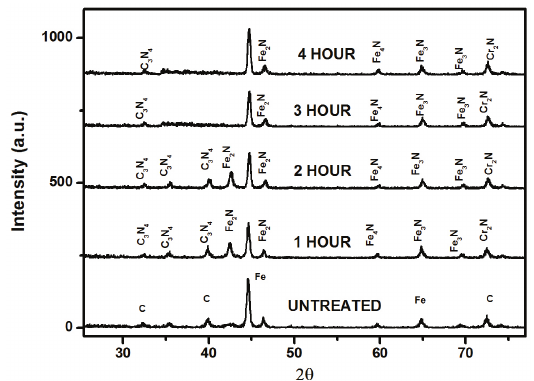
Figure 4. X-ray diffraction patterns of high carbon steel samples nitrided for different treatment